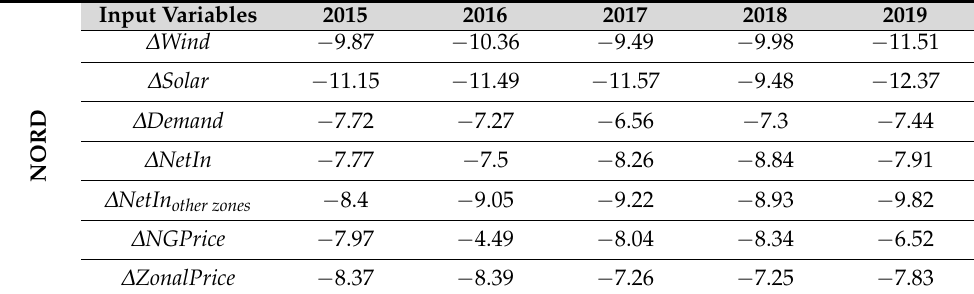
Table A3. Augmented Dickey–Fuller test statistics in 1st difference;